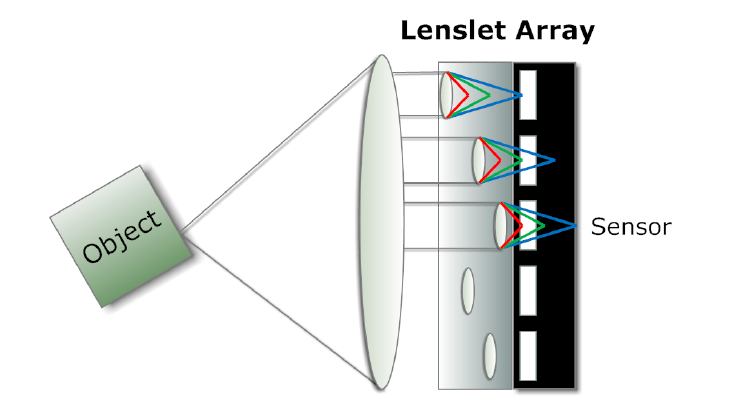
Figure 5. Example of a lenslet array, where the wavelengths are selected according to the distance between each lens and the corresponding